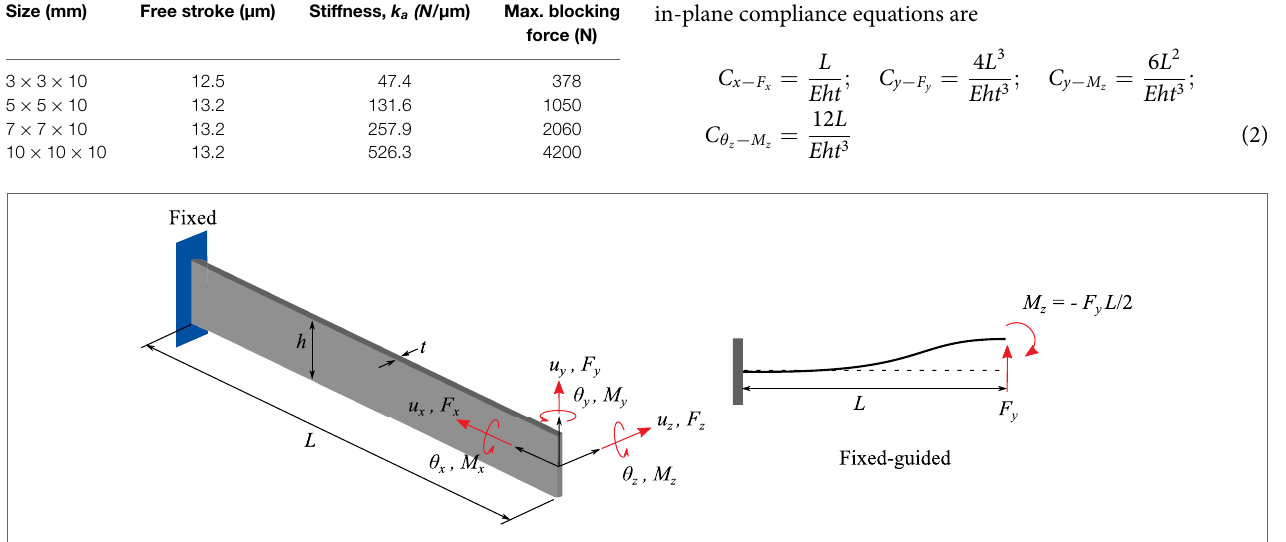
Fr ontiers in Mechanical Engineering |